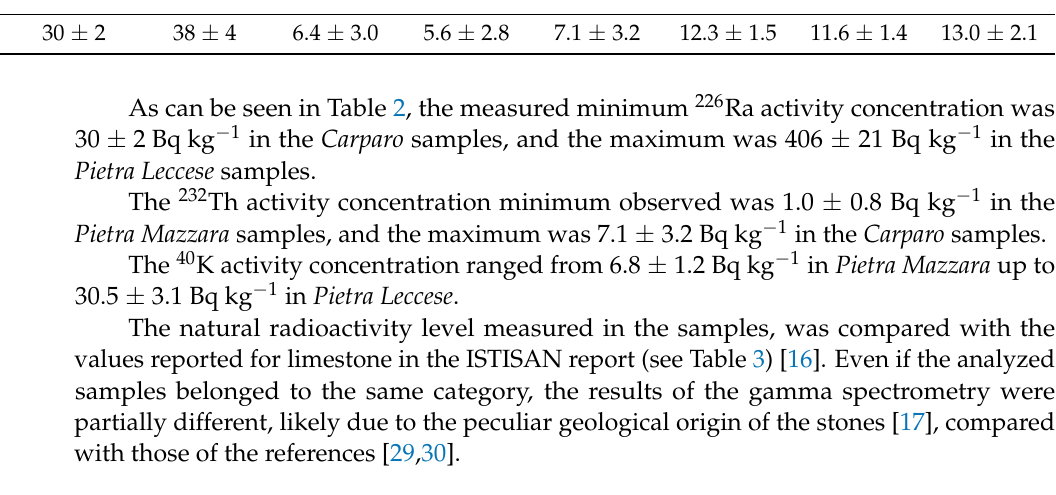
Pietra Leccese Pietra Mazzara